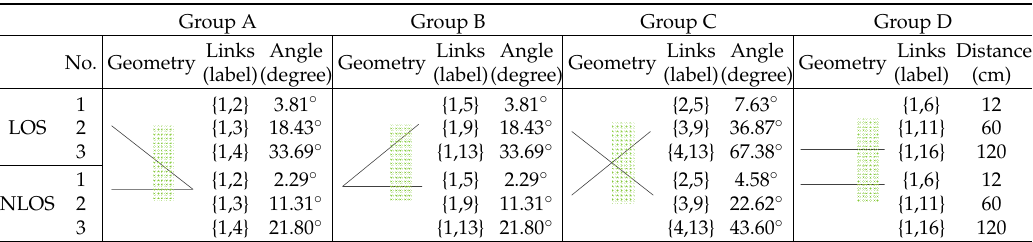
Figure 8. Average accuracy and standard deviation with respect to different single links. ( a ) VQ with LOS; ( b ) HMM with LOS; ( c ) VQ with NLOS; ( d ) HMM with NLOS. Table 1. Typical groups of dual-link and